Question: Reading the figure, is the described quantity rising or falling?
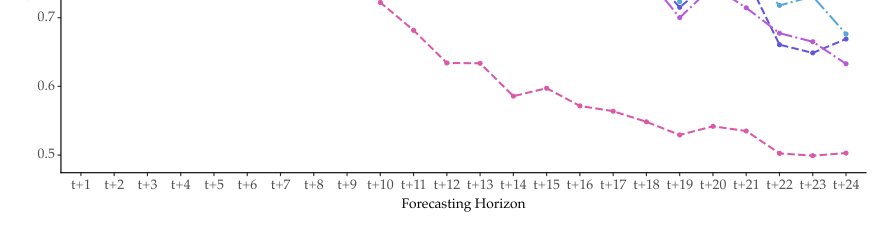
Answer: decreasing